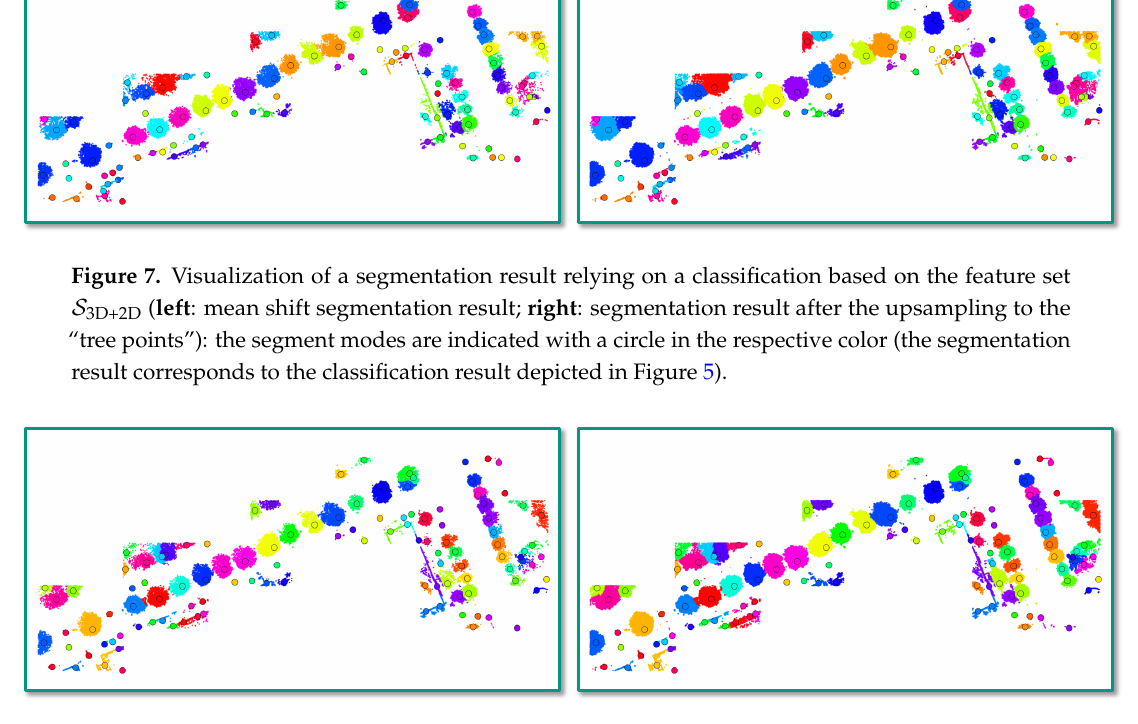
Figure 8. Visualization of a segmentation result relying on a classification based on the feature set S FCBF ( left : mean shift segmentation result; right : segmentation result after the upsampling to the “tree points”): the segment modes are indicated with a circle in the respective color (the segmentation result corresponds to the classification result depicted in Figure